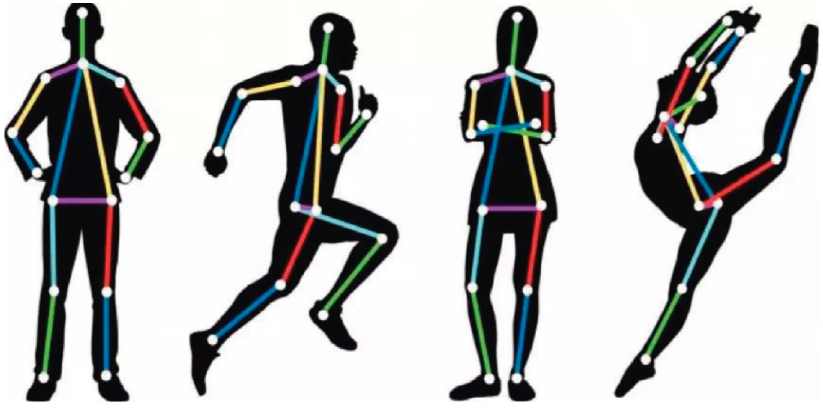
Figure 1: Video behavior